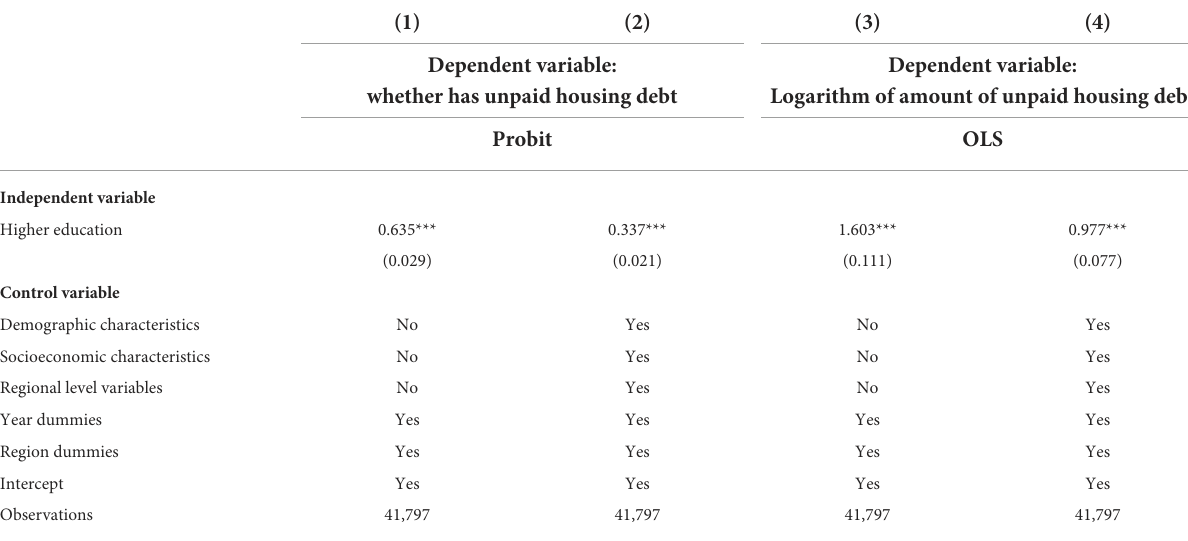
TABLE 8 Relationship between higher education and unpaid